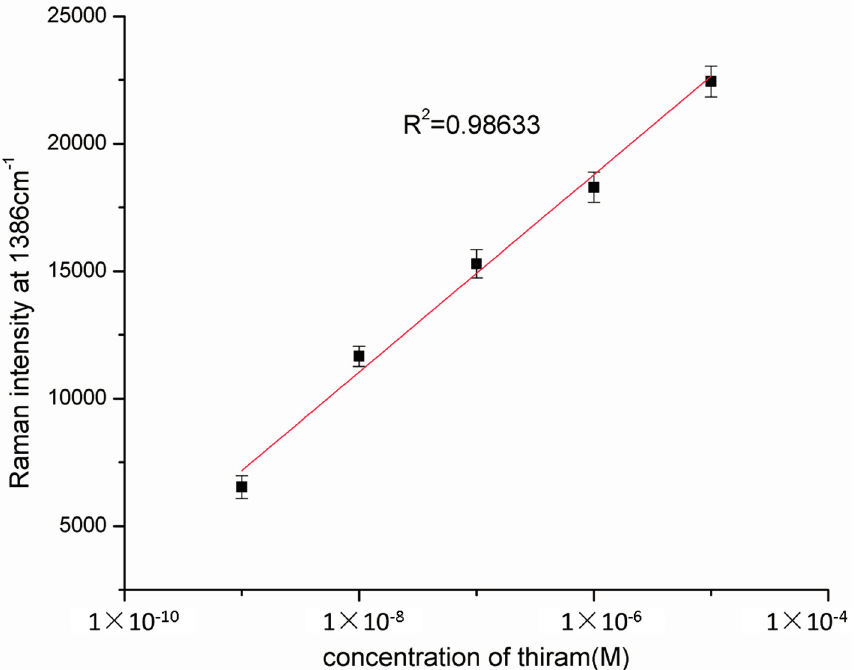
Figure 9. Variations of thiram peak intensity at 1386 cm − 1 of SERS spectra as a function of thiram